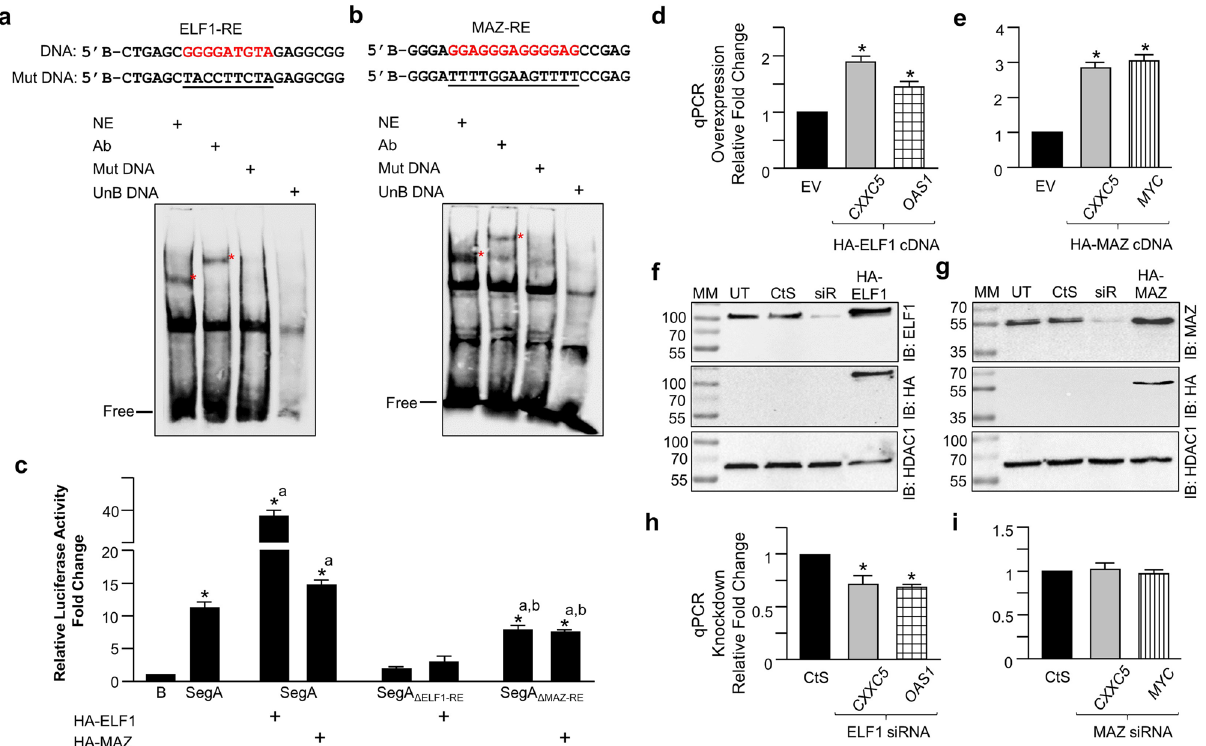
Figure 6. Assessing the interaction of ELF1 or MAZ with DNA. ( a , b ) Electrophoretic mobility Shift Assay (EMSA). 40 fmol of 5 ′ biotin-conjugated doubled stranded DNA fragment (shown is the upper strand) containing the wild type (red font) or mutant (underlined) ELF1 or MAZ response element (RE) derived from the CXXC5 core promoter was incubated with nuclear extracts (NE, 45 µg) of MCF7 cells in the absence or presence (+) of an antibody (Ab) or 250-fold excess unbiotinylated DNA (UnB) with wild type RE. Free indicates the unbound biotinylated RE. Asterisks (red) indicate protein-bound DNA. ( c ) MCF7 cells were transfected with pGL3 bearing none (B), the wild-type (SegA), or Segment A with a deletion of ELF1-RE (SegA ΔELF1-RE ), or MAZ-RE (SegA ΔMAZ-RE ) as promoter driving Luciferase cDNA expression as the reporter without or with an expression vector bearing the HA-ELF1 or HA-MAZ cDNA for 24 h. The transfection efficiency was monitored by the co-expression of pCMV-Renilla Luciferase. Cellular extracts were then subjected to dual-luciferase assays. Asterisks (*) indicate significant differences depicted as fold change compared to B which was set to 1; whereas the superscript “a” denotes significant differences compared to SegA. ( d , e ) MCF7 cells were transfected with an expression vector bearing none (EV), HA-tagged ELF1, or HA-tagged MAZ cDNA. Isolated RNA was converted into cDNA libraries and followed by qPCR using either CXXC5 -specific or OAS1 -specific for ELF1 control or MYC -specific for MAZ control primers. Results were normalized with the RPLP0 expression using the 2- ΔΔCT method. ( f , g ) Nuclear extracts of untransfected (UT) or transiently transfected MCF7 cells with control siRNA (CtS), a pool of siRNA specific (siR) to ELF1 ( f ) or MAZ ( g ), or with an expression vector bearing the HA-ELF1 or the HA-MAZ cDNA for 48 h were subjected to IB using ELF1 or MAZ antibody. Membranes were then re-probed with the HA antibody. Molecular masses (MM) in kDa are indicated. ( h , i ) Total RNA from MCF7 cells transiently transfected cells with control siRNA (CtS), siRNA specific (siR) to ELF1 ( h ), or MAZ ( i ) were processed for and subjected to qPCR using primers specific to CXXC5 , the OAS1, or MYC . Asterisks (*) denote significant differences depicted as fold change compared to CtS of three independent